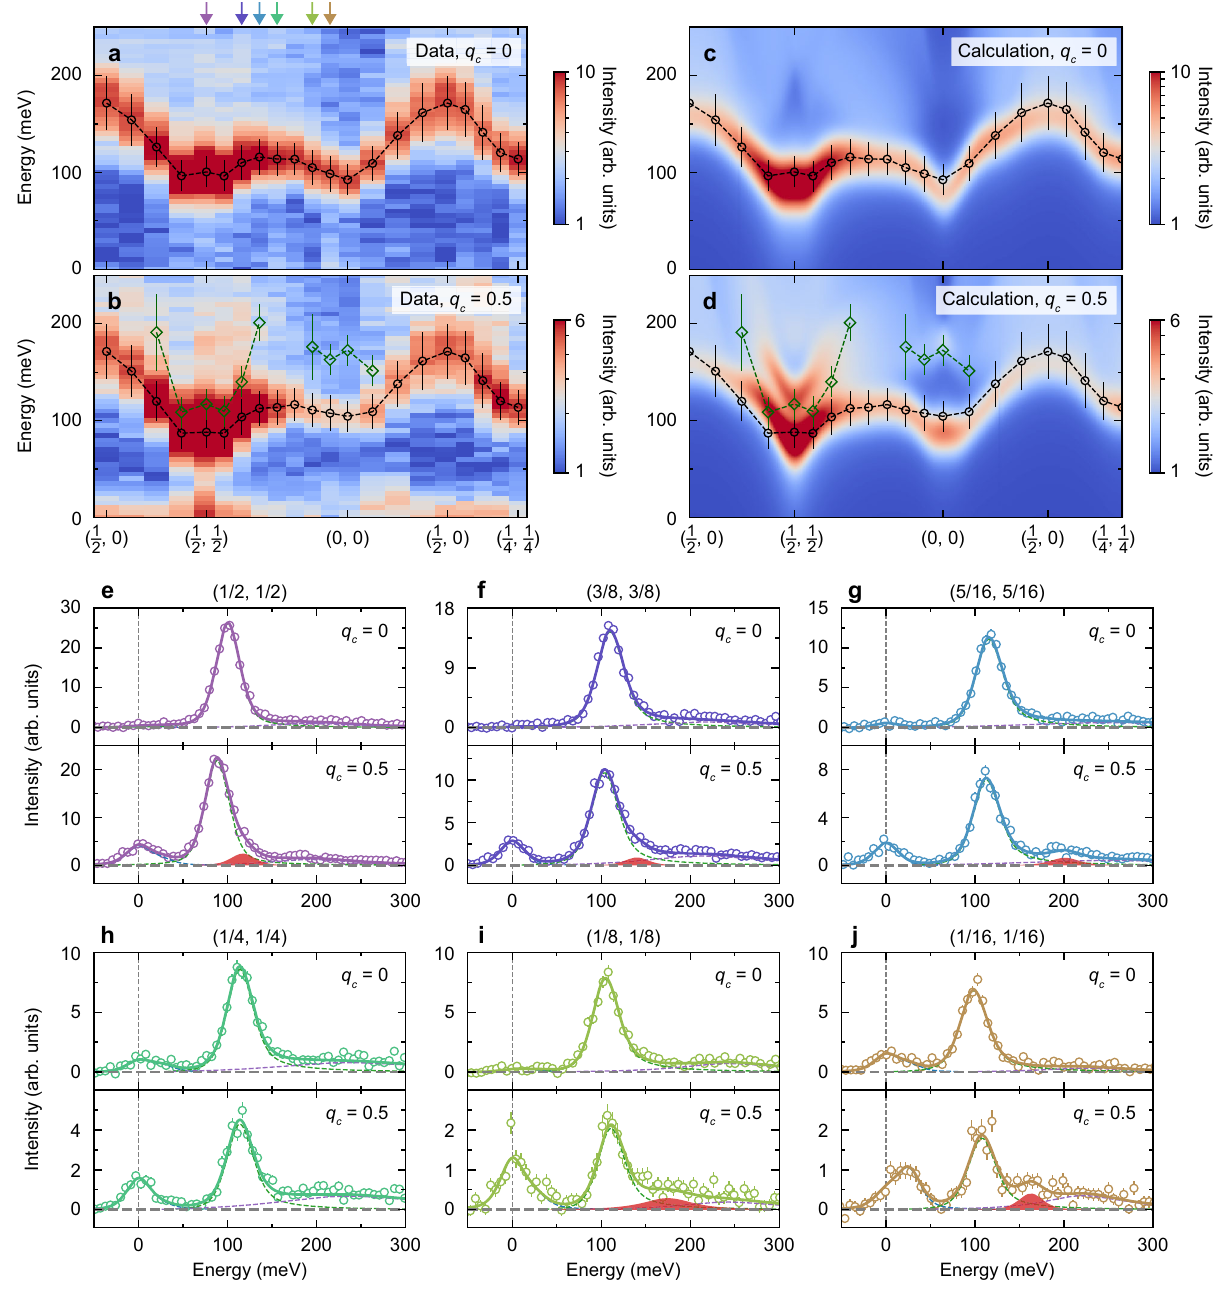
Fig. 3 Magnetic dispersion and excitonic longitudinal mode decay. a , b In-plane momentum dependence of the magnetic excitations measured at q c = 0 and 0.5. The black and green symbols correspond to the energy of the magnetic modes and the vertical bars to their peak widths. Both quantities were extracted from the energy spectra at different points in reciprocal space (such as shown in panels e – j and Fig. 2c – e). c and d Theoretical calculations of the magnetic dispersion relation, overplotted with the experimentally determined excitation energies and line widths. The presence of the mode at q c = 0.5 that is absent at q c = 0 evinces that this is an excitonic longitudinal mode. e – j RIXS spectra at reciprocal space as highlighted by color-matching arrows in panel a . Circles represent the data and dotted lines outline the different components of the spectrum, which are summed to produce the solid line representing the total spectrum. Error bars are determined via Poissonian statistics. The isolation of the longitudinal mode (highlighted with red shading) from other contributions was possible by simultaneously analyzing q c = 0.5 and q c = 0 for each in-plane reciprocal-lattice wavevector (see Methods section for